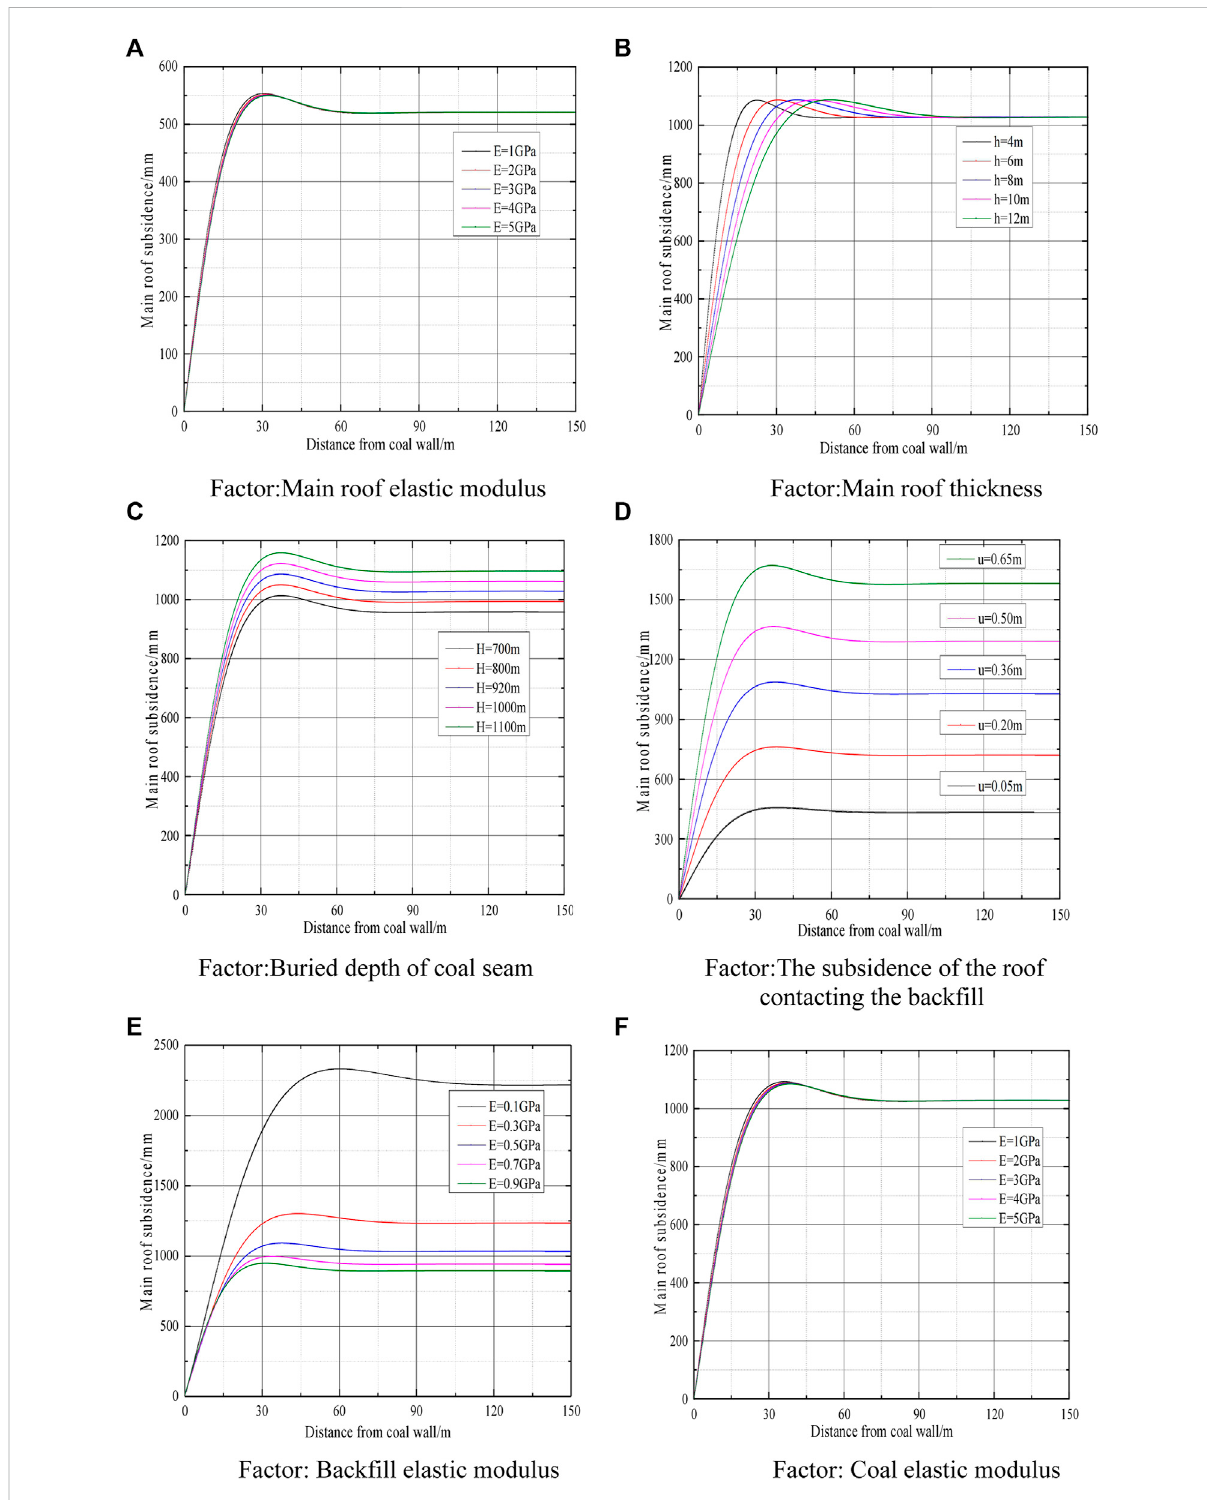
FIGURE 5 Schematicdiagramofthein fl uenceofvarious factorson themainroofsubsidence(lowerslicingmining). (A) Factor:mainroofelasticmodulus. (B) Factor: main roof thickness. (C) Factor: buried depth of the coal seam. (D) Factor: the subsidence of the roof contacting the back fi ll. (E) Factor: back fi ll elastic modulus. (F) Factor: coal elastic